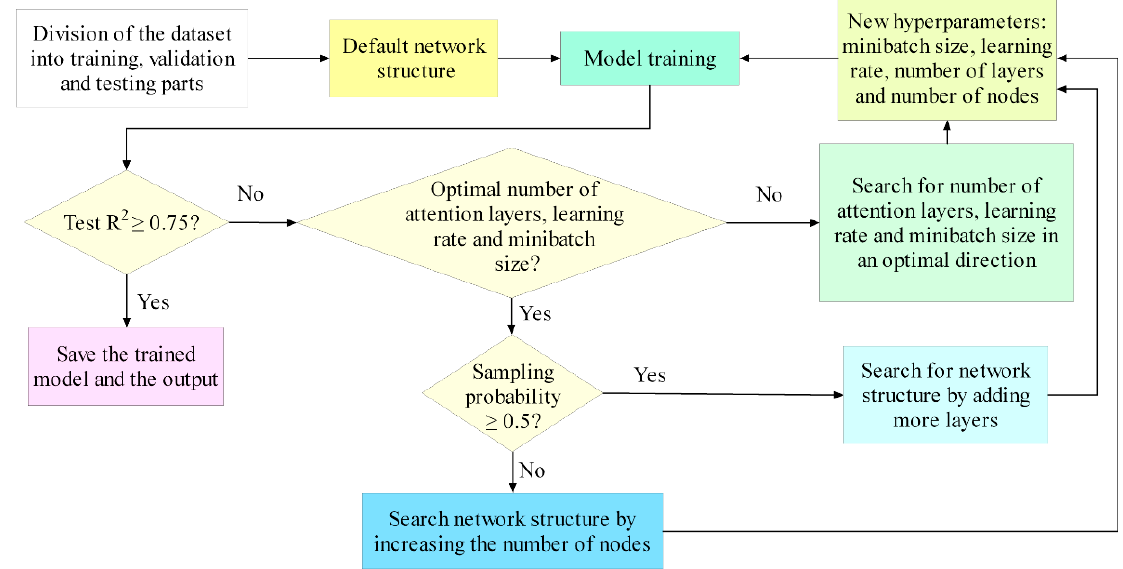
Figure 1. Procedure of heuristic grid search to find optimal hyperparameters.